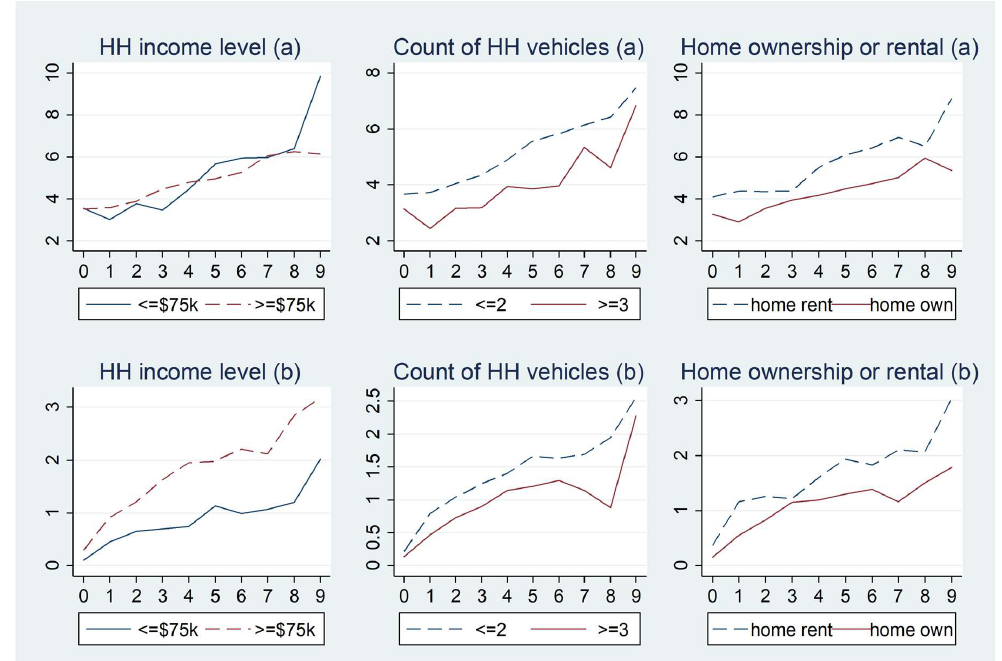
Figure 4. Relationship between ridesharing and public transit use varying by race, worker, and driver status for those who use ridesharing in the past 30 days: (a) 1–99 times; (b) 0–99 times.